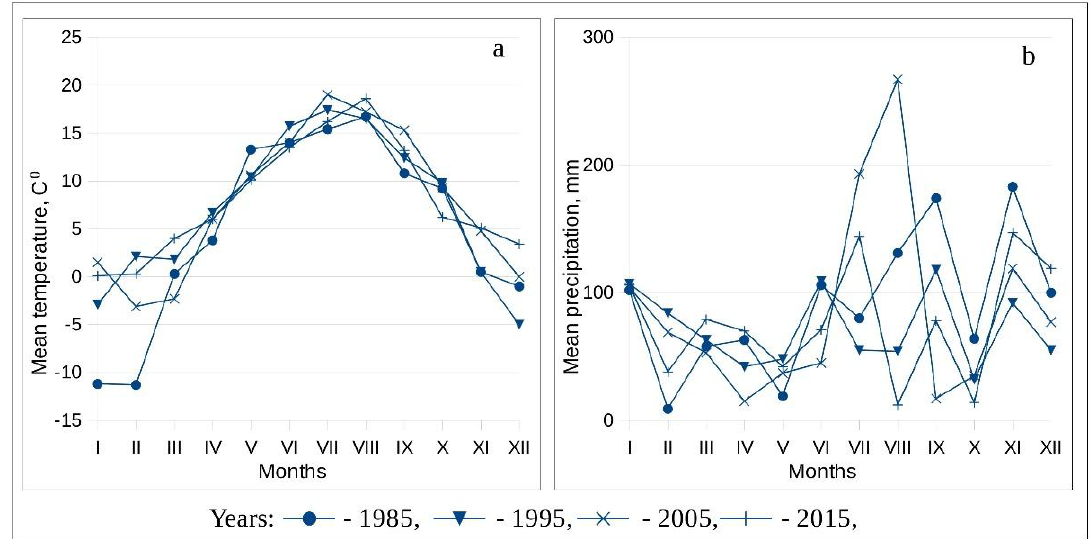
Figure 1. Dynamics of the main gradients of climate—temperature ( a ) and precipitation ( b ) according to data of meteorological station “Vėžaičiai” located 7 km from the trial location.